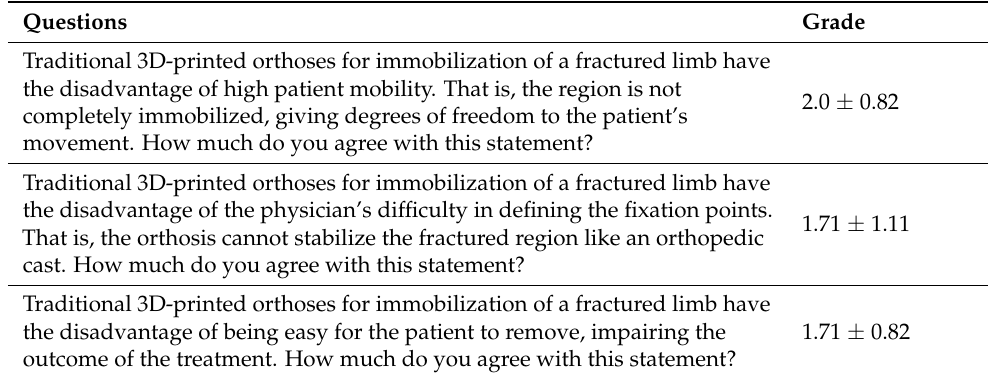
Table A2. Questions about 3D printed orthoses with grades.